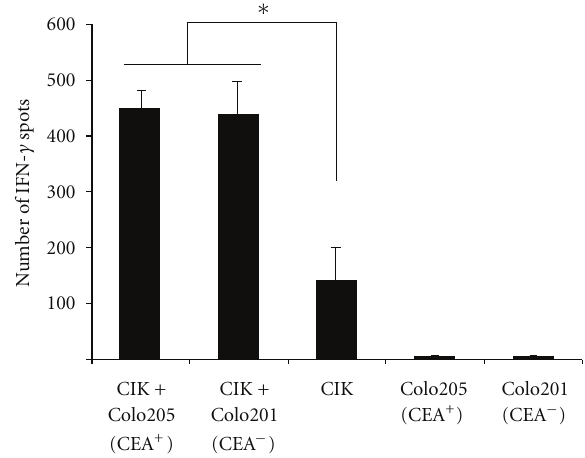
Figure 1: CIK cells are equally activated upon binding to CEA + and CEA − tumour cells. CIK cells (4 × 10 4 cells) generated from blood lymphocytes of healthy donors were coincubated with CEA + Colo205 or CEA − Colo201 tumour cells (10 3 tumour cells) for 48hrs. IFN- γ production was monitored by ELIspot analysis. Data represent the mean ± standard error of the mean; a representative experiment out of three is shown. ∗ P < 0 .